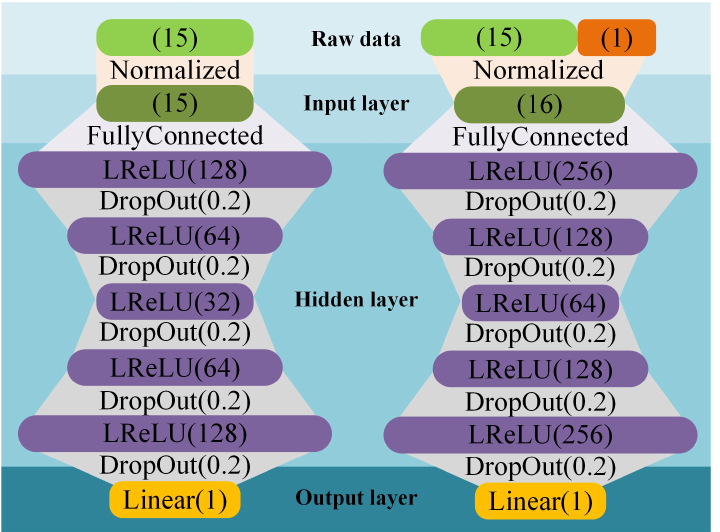
Figure 3. Structures of the neural networks (( Left ) AN. ( Right ) CN) with theparameters of each